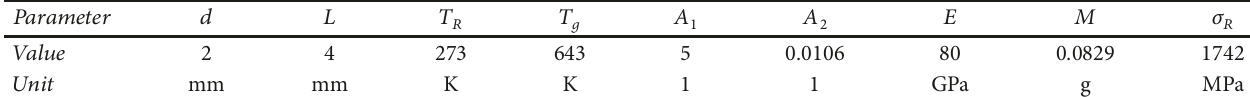
Table 1: The parameters for the metallic glass Cu 50 Zr 45 Ti 5 during the plastic deformation.